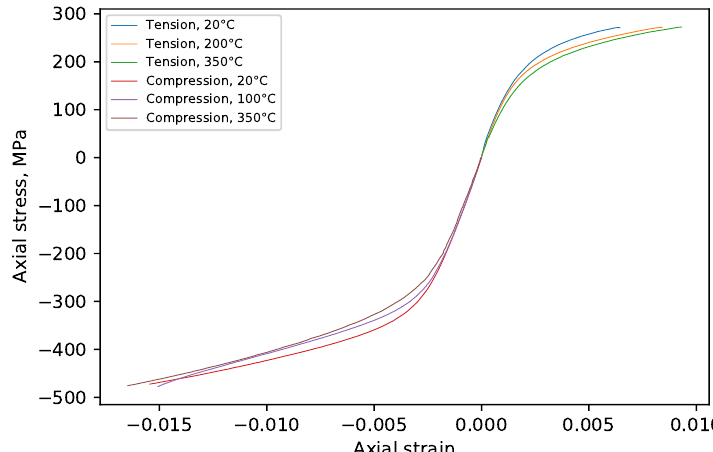
Figure 6. Experimental results for tension and compression at different temperatures.